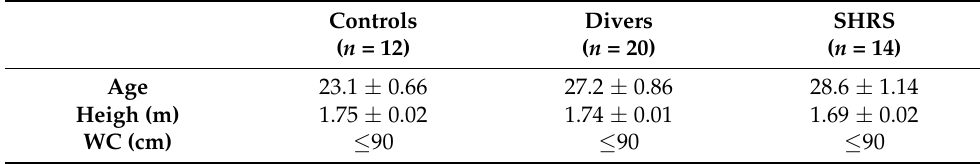
Table 1. Characteristics of subjects included in the study. Data are mean ± SEM. Controls Divers